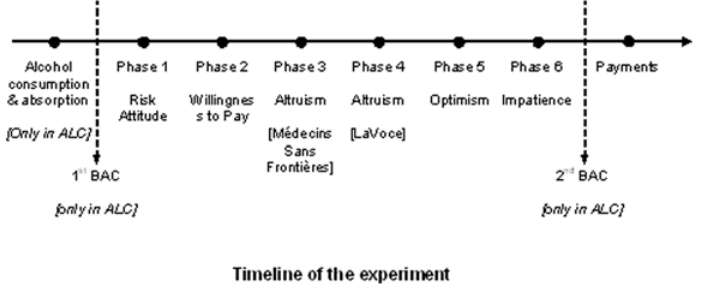
Fig 1. Timeline of the Experiment.